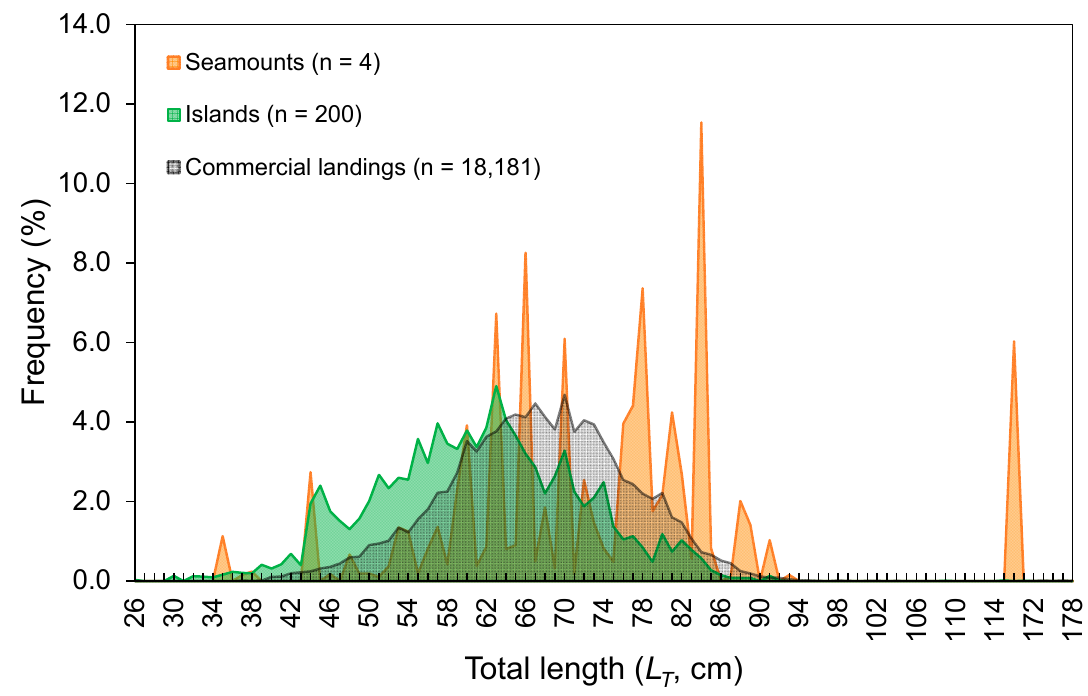
Figure 3. Total length ( L T )–frequency distribution of the thornback ray Raja clavata derived from scientific surveys (1996–2019) and official commercial landings (1990–2017) in the Azores. For the surveys, data are shown separately for seamounts and islands, and the number of individuals (n) refers to the total RPN (ind. 10 − 3 hooks).